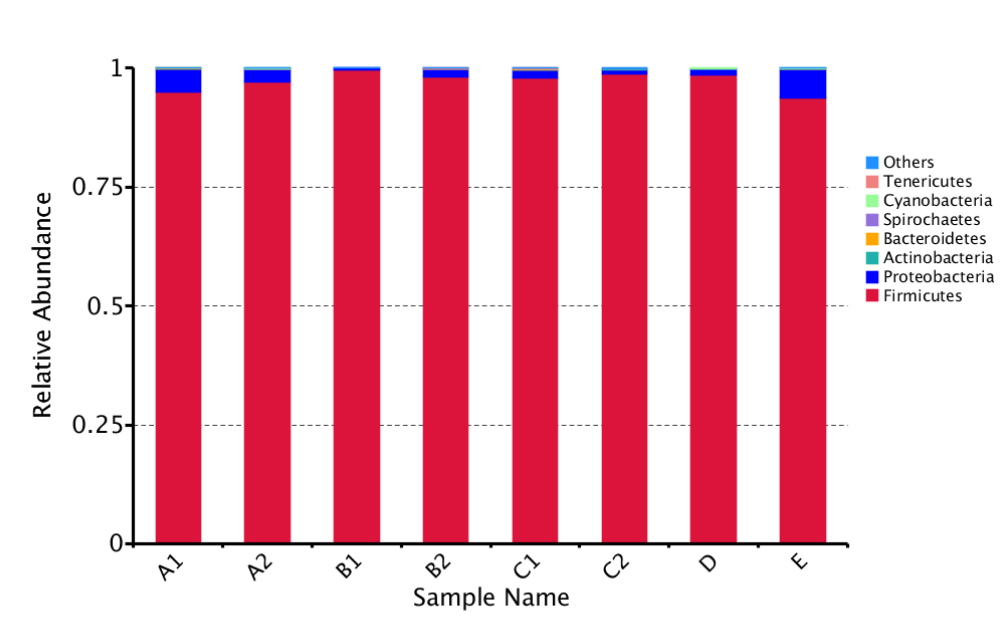
Figure 1. Bacterial phylum level composition in honey from eight different stingless bee species. Color-coded bar plot showing the average bacterial phylum distribution of the different groups sampled from honey of various stingless bee species (A1— Heterotrigona itama ; A2— Heterotrigona erythrogastra ; B1— Tetrigona apicalis ; B2— Lepidotrigona terminata ; C1— Tetrigona melanoleuca ; C2— Tetrigona bingami ; D— Geniotrigona thoracica ; E— Homotrigona fimbriata ).